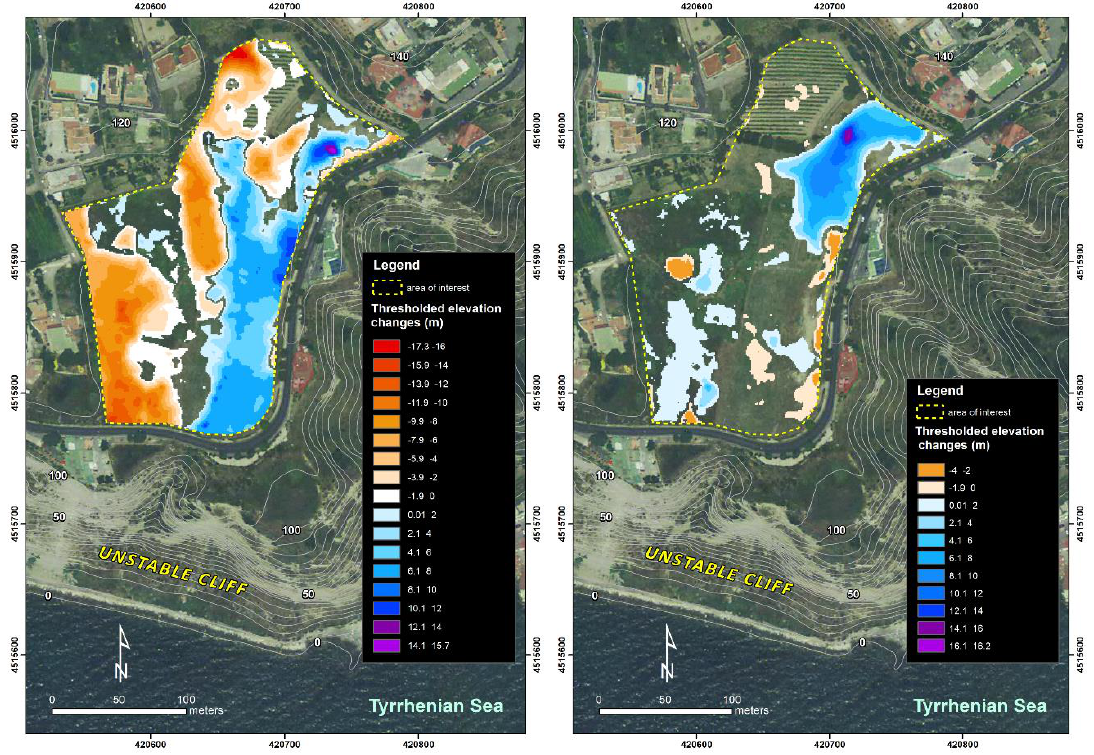
Figure 5. Digital elevation models (DEMs) of difference.